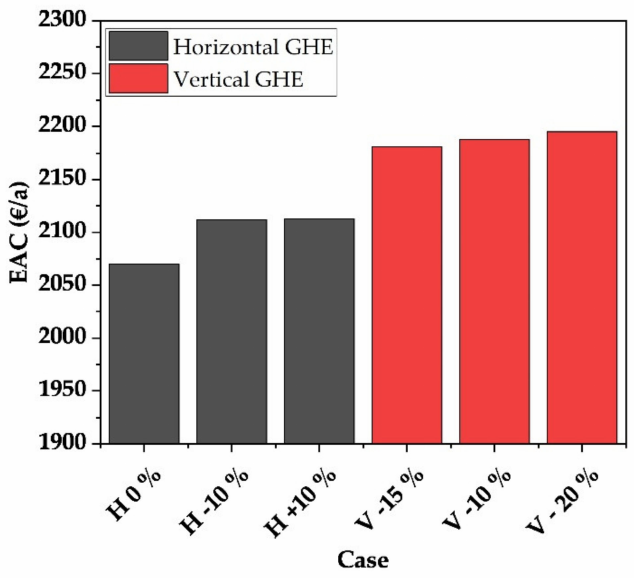
Figure 10. Total cost for heating and cooling per consumer for each case in the region of